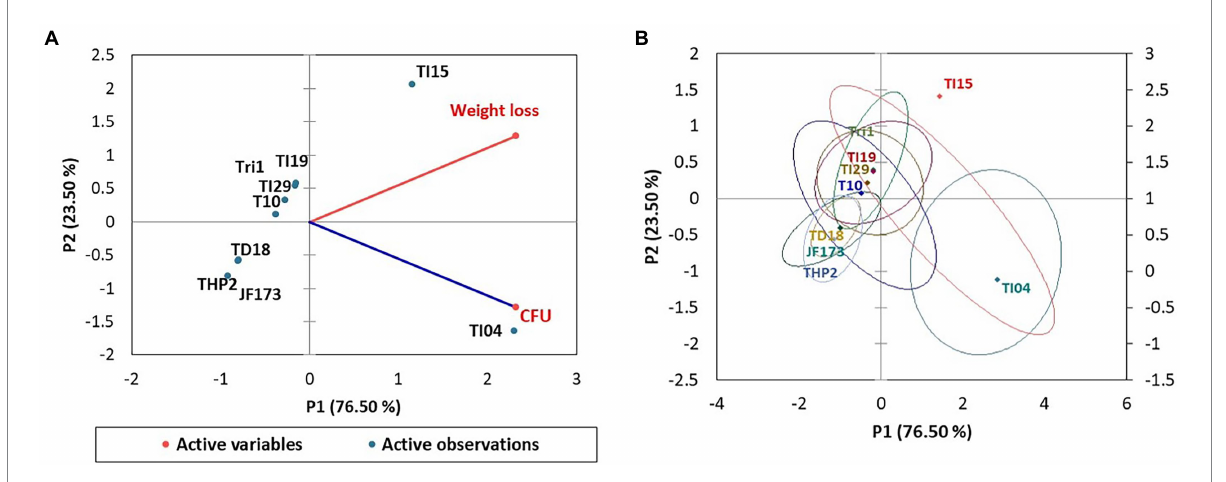
FIGURE 5 PCA plot of the growth pattern of nine Trichoderma isolates on Eucalyptus leaves. (A) A biplot of spore density and leaves weight loss. (B) Bootstrap ellipses-based spore density and leaves weight loss.